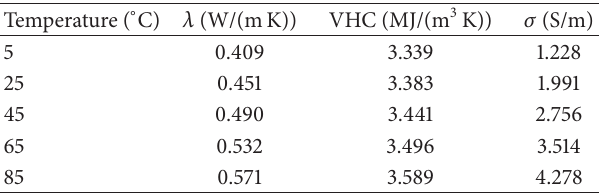
Table 1: Benchmarked mesh set. Mesh elements